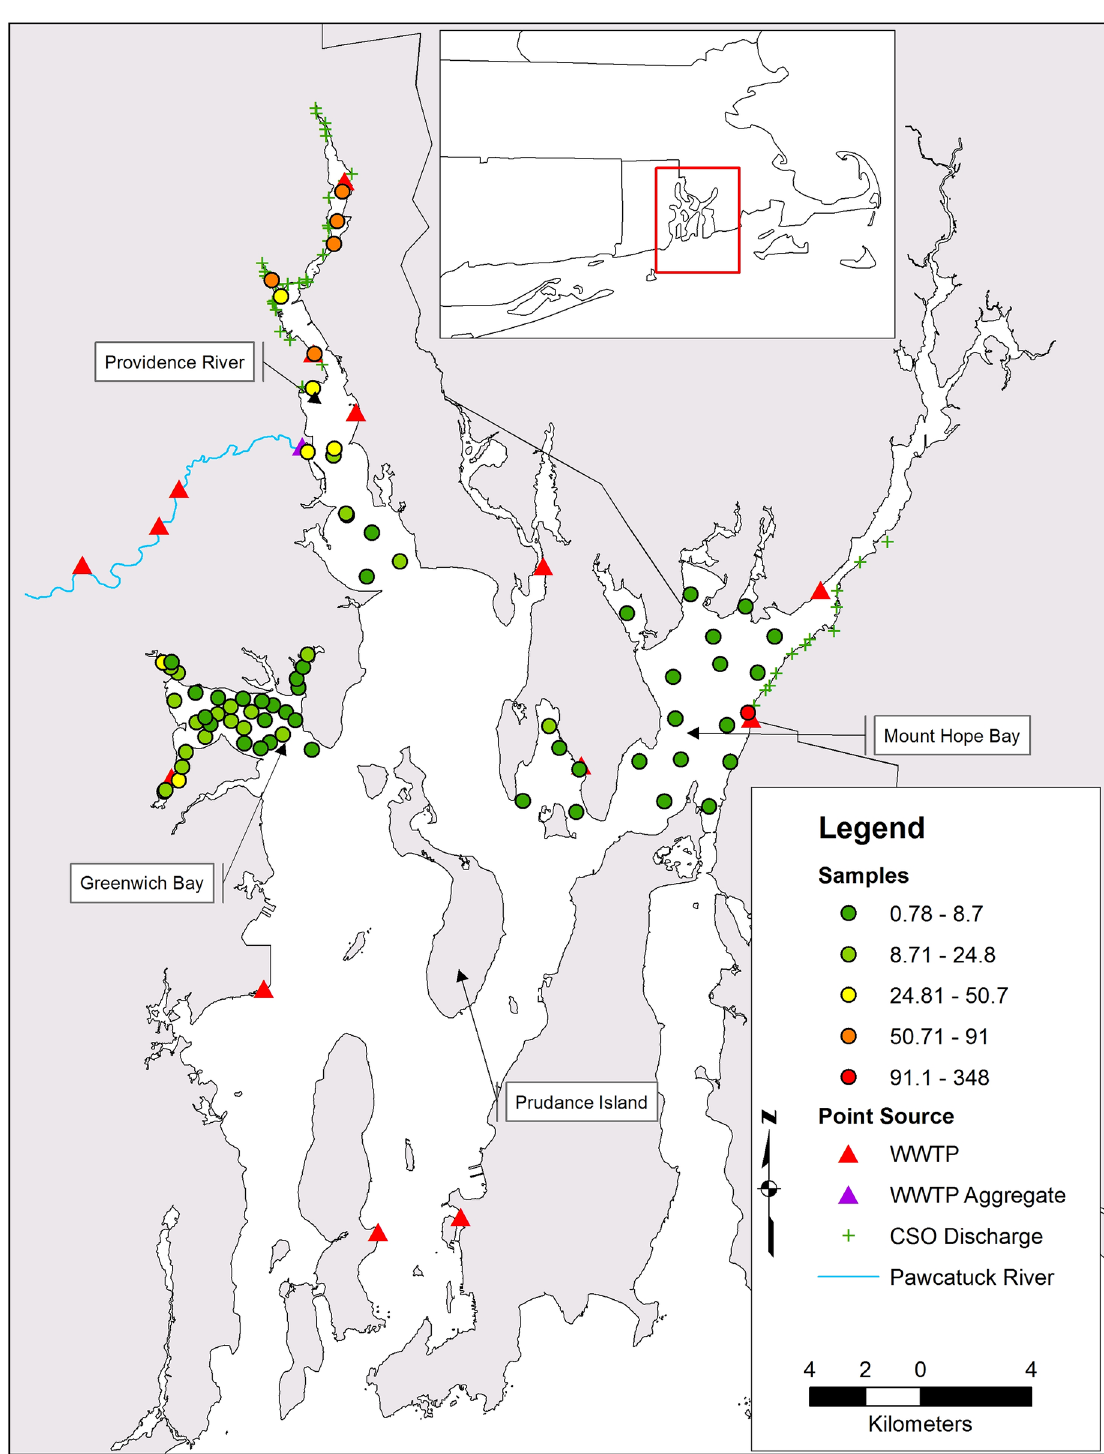
Fig 1. Distribution of triclosan training data and point source predictor variables in Narragansett Bay, RI. A sample’s color representsthe observedsedimenttriclosan concentration (ng g − 1).